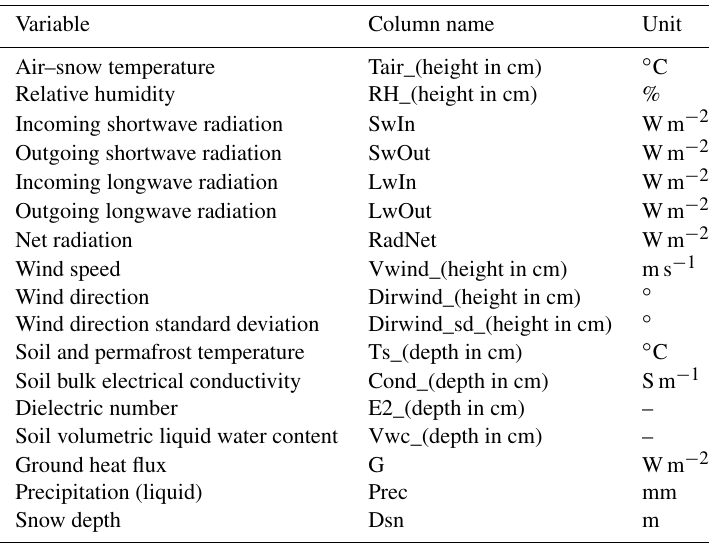
Table G1. Overview of all variables provided as time series. The variables electric conductivity, dielectric number, soil temperature and volumetric soil liquid water content include a second number or letter in the column name. In these cases, the first number is the distance in the 2-D profile and the second is the depth. The single letters (a, b, c, d) refer to the different 1-D profiles. Vertically oriented probes are marked with letter (v). Additional level 2 data are provided for the variables snow depth, soil temperature and volumetric soil liquid water content, which is indicated by “_lv2” in the column names. If an air temperature sensor is covered by snow and thus measures snow temperature, this is indicated by a flag in the